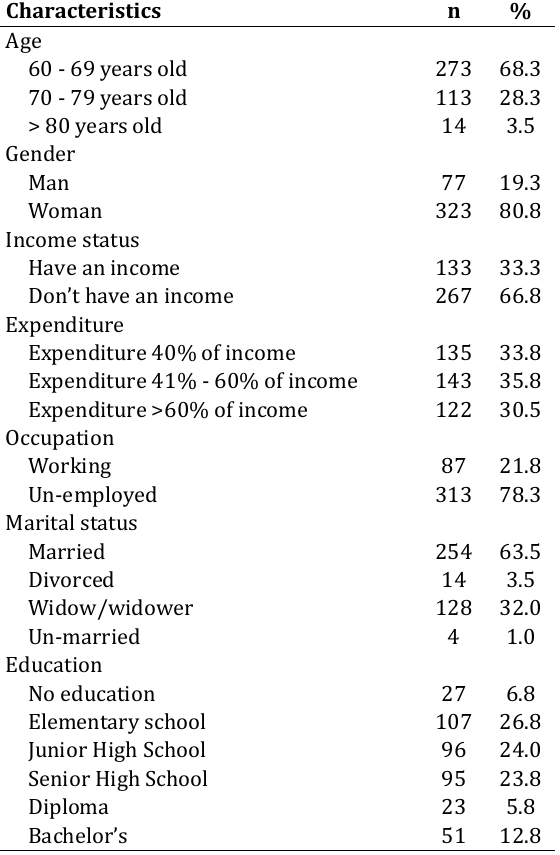
Table 1. Characteristic of Respondents (n=400)